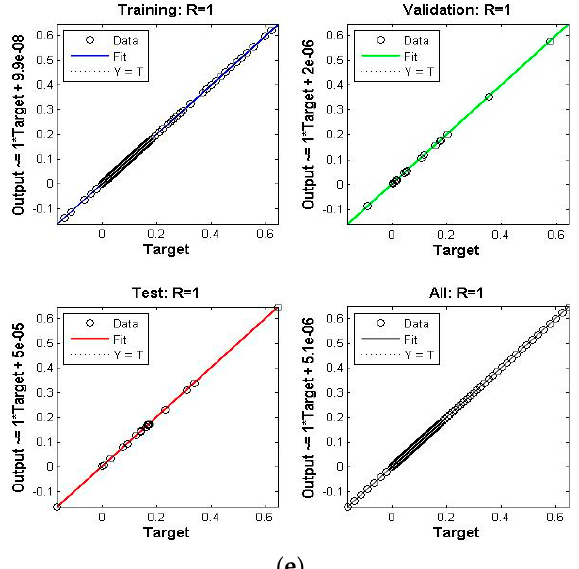
Figure 6. Scenario III Case I of TD-PNFM. ( a ) MSE Results: Scenario III Case I; ( b ) Transition state: Scenario III Case I; ( c )